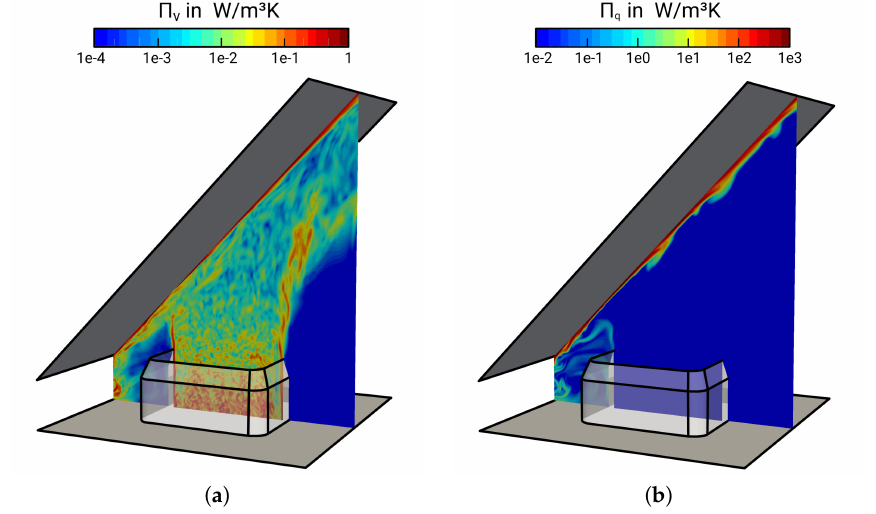
Figure 10. Snapshots of entropy generation rate by ( a ) viscous dissipation and ( b ) heat transport at the mid-plane section of the inclined impinging